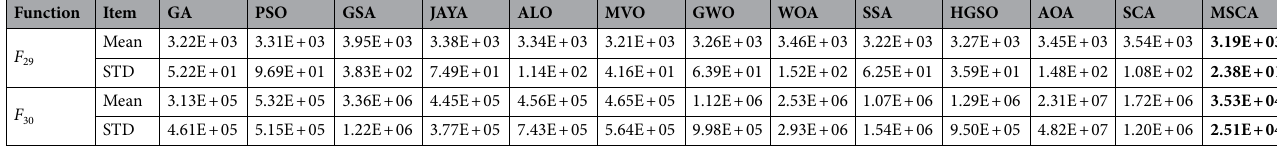
Table 7. Statistic result of the algorithms on CEC2017 test suit with 10 dimensions. Significant values are in bold.